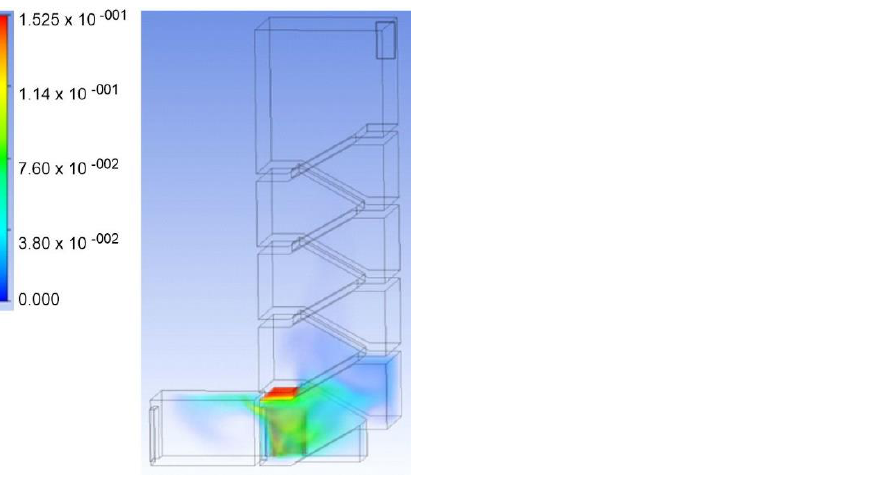
Figure 3. Carbon dioxide distribution 2 s after the door was opened. Carbon dioxide was measured as a mass fraction.